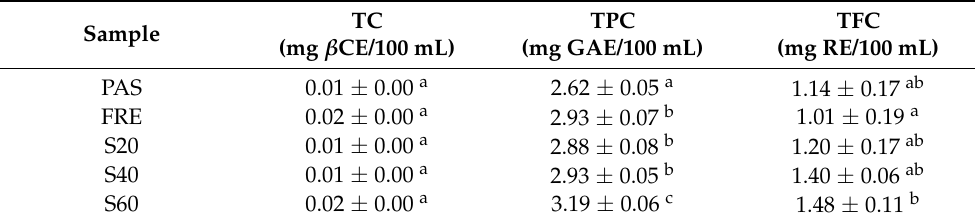
Table 2. Total carotenoids, phenolics, and